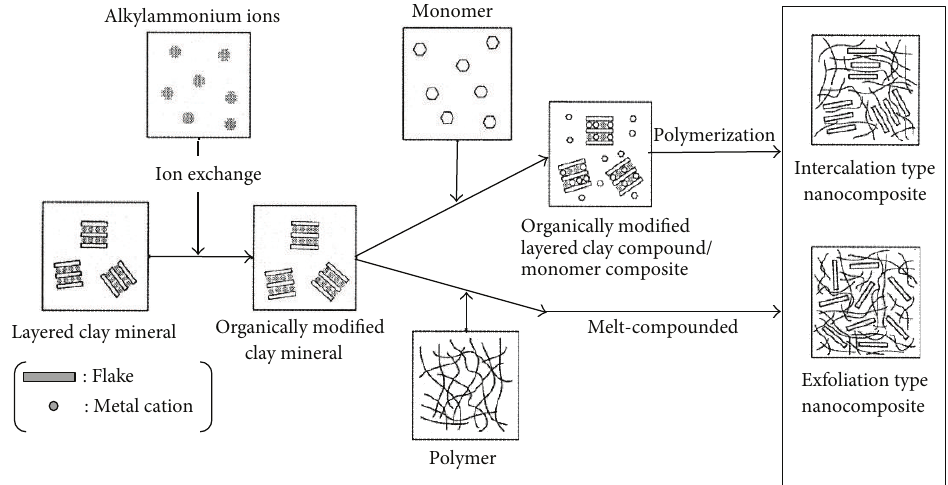
Figure 8: Intercalation and exfoliation process of nanocomposites